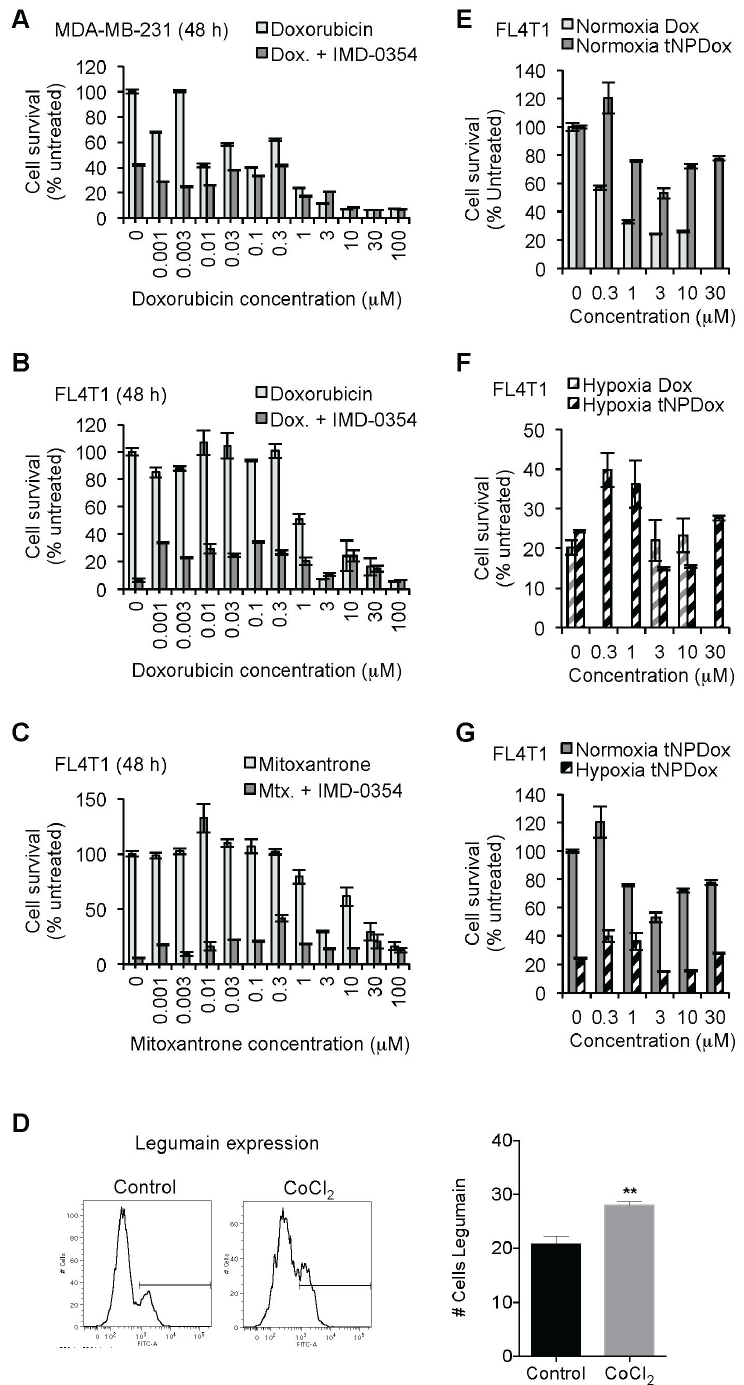
Figure 6. Combination therapy and tNP drug delivery in vitro . Viability of MDA-MB-231 cells was assessed by MTT assay after treatment with doxorubicin alone or in combination with IMD-0354 for 48 h (A). Viability of FL4T1 cells was assessed by MTT assay after treatment with doxorubicin (B) or mitoxantrone (C) alone or in combination with IMD-0354 for 48 h. Surface extracellular display of legumain on 4T1 cells assessed by FACS under normoxia (control) and hypoxia (CoCl was assessed by MTT assay after treatment with free doxorucibin and tNP-doxorubicin for 48 h under normoxia (E) and hypoxia (F); same data as in E and F, plotted to compare tNP-Dox effect on FL4T1 viability under normoxia and hypoxia. Data are shown as mean ± SEM. doi: 10.1371/journal.pone.0073607.g006 PLOS ONE |